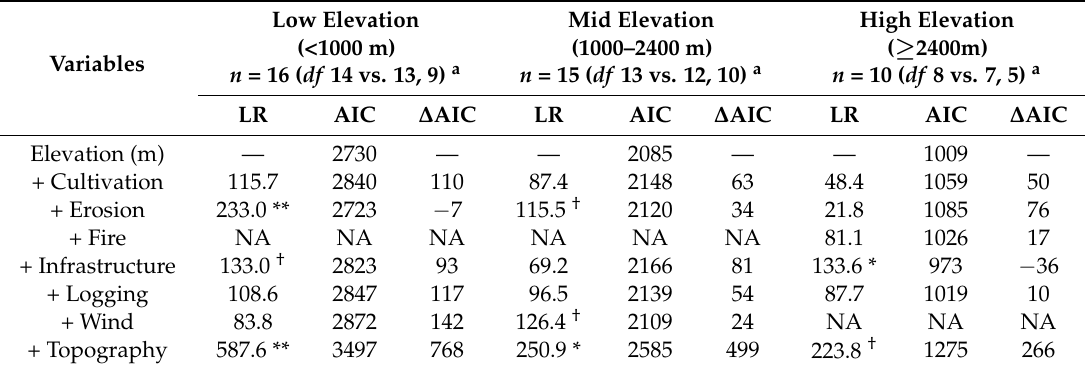
Table 2. Summary of model comparisons between elevation effect alone and elevation effect plus one of the other environmental effects at three elevation